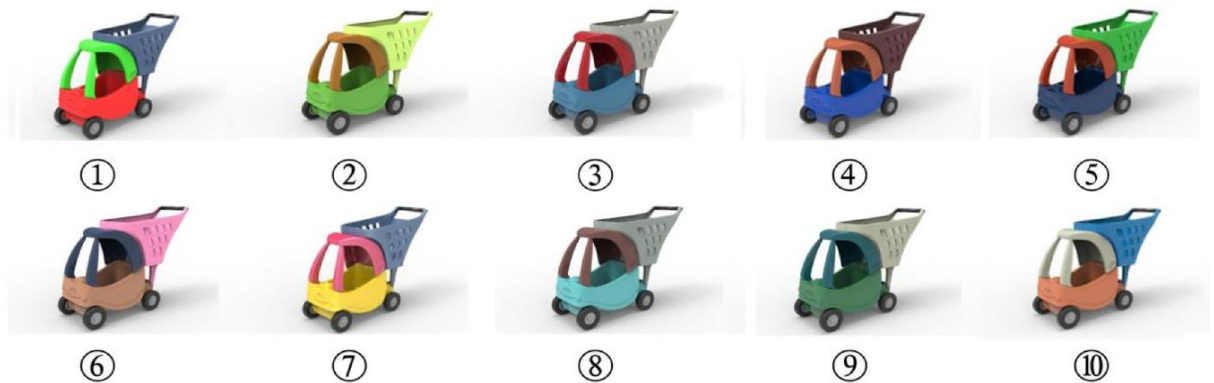
Figure 4. Validation of the three-color children’s shopping cart color scheme used.